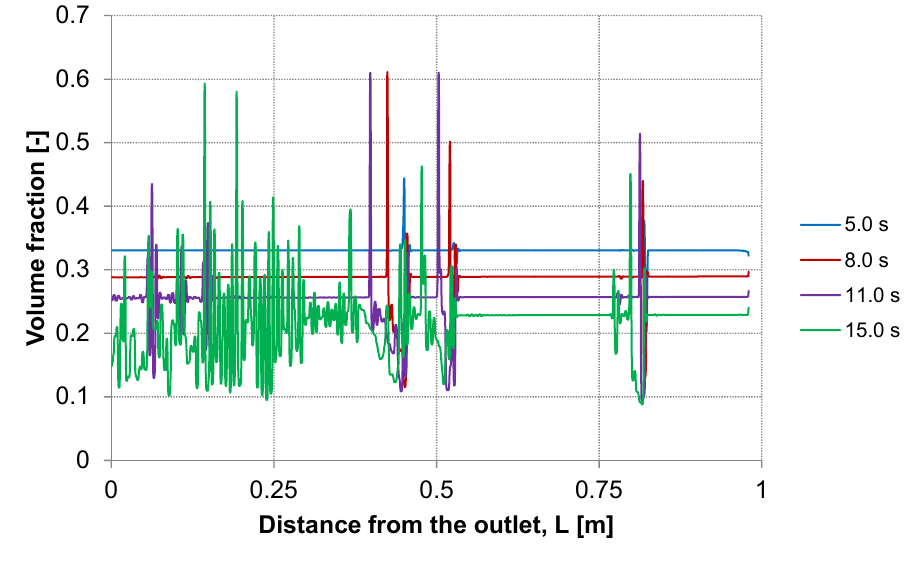
Figure 18. Particle distribution at control line E with backwashing flux of 100 L m − 2 h − 1 , (deposited layer as initial